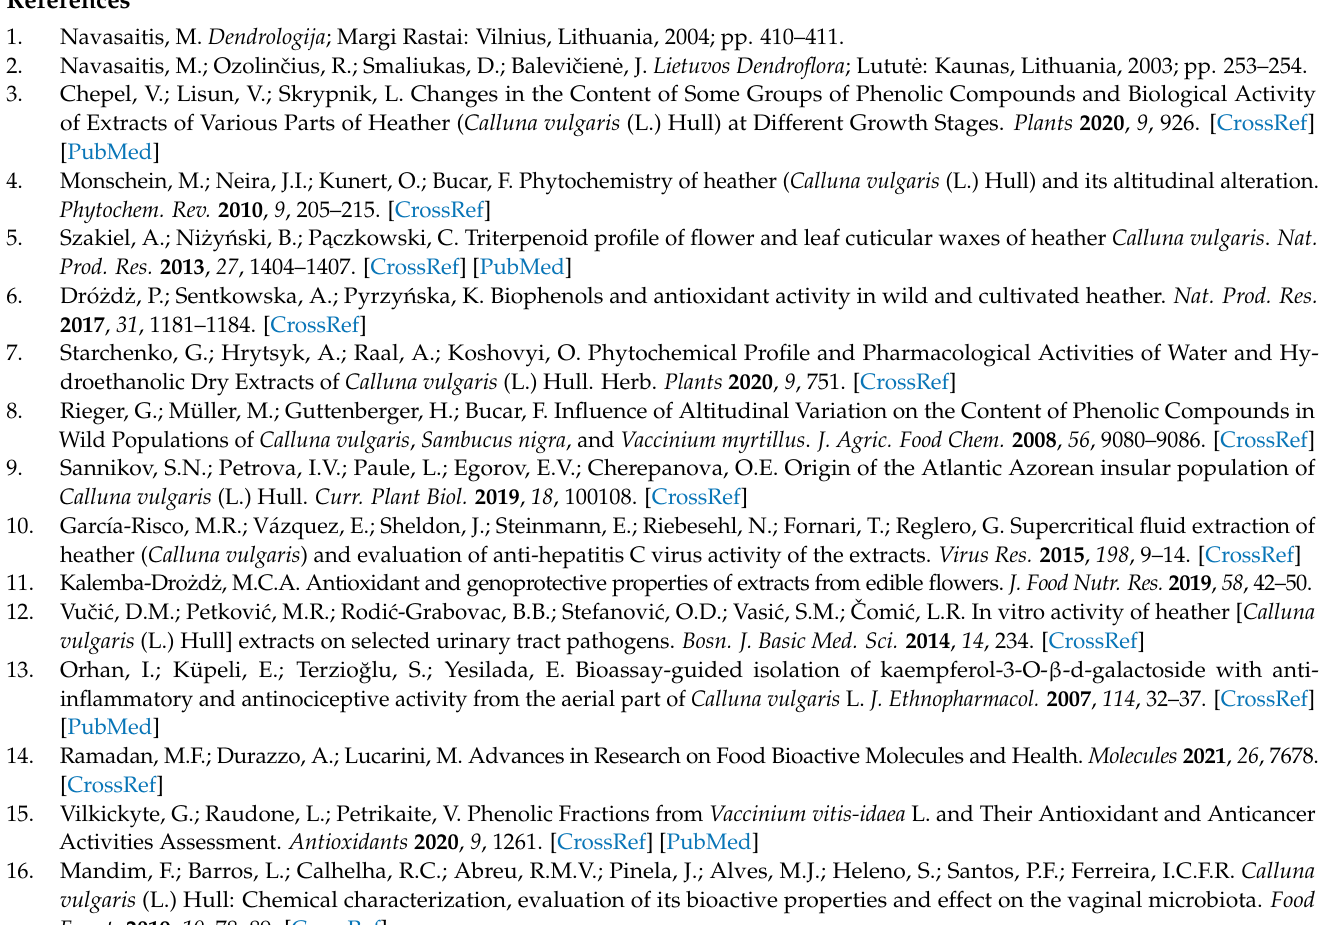
Table S2. The amounts of precipitation (mm) during the vegetation period (April–September 2020) in the areas of investigated populations of C. vulgaris; Table S3. The sunshine duration (h) during the vegetation period (April–September 2020) in the areas of investigated populations of C. vulgaris; Table S4. The soil type and soil pH in the areas of investigated populations of C. vulgaris